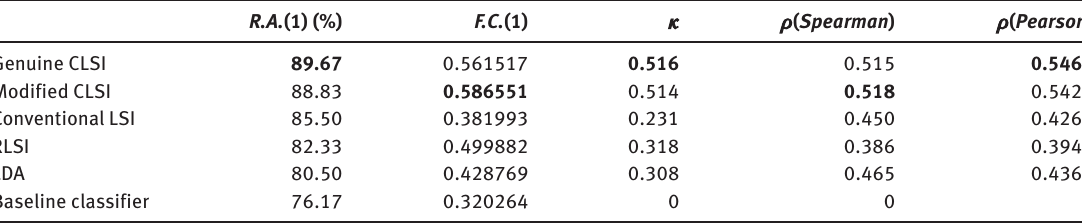
Bold values mean the best results.